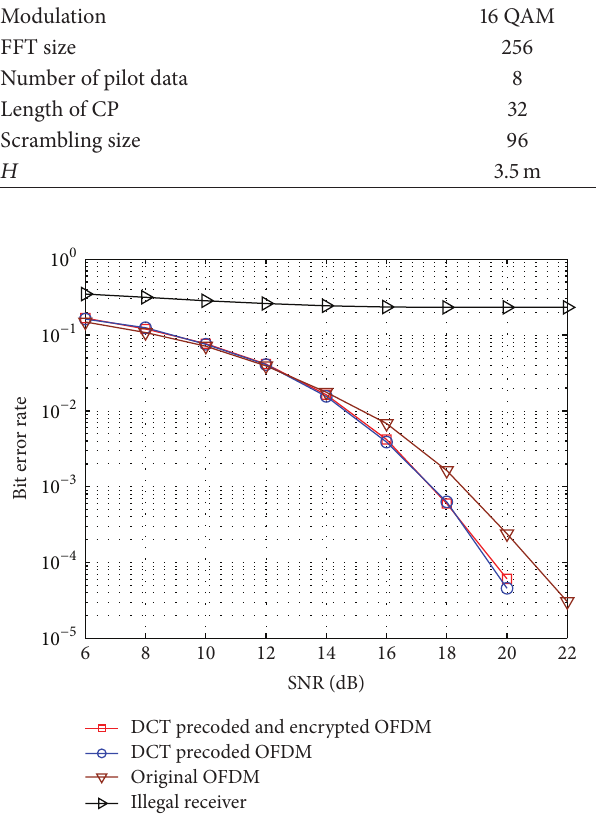
Figure 10: BER performance for multipath optical wireless channel.